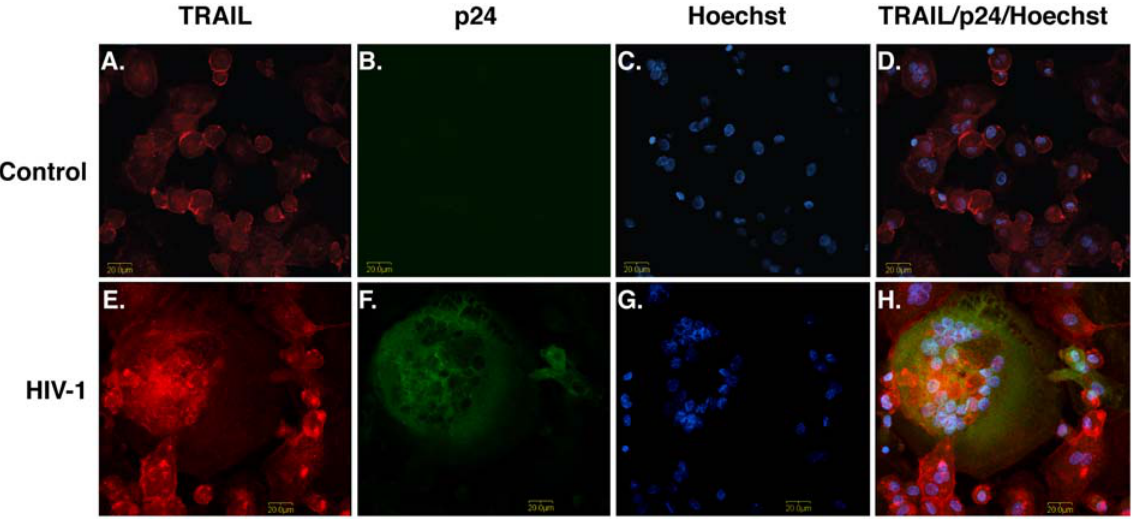
Figure 2. Membrane-bound TRAIL increases in HIV-1-infected macrophage culture. Human MDM were infected with HIV-1 for 5 days and then stained with antibodies to p24 (HIV-1 infection marker, green) and TRAIL (red). Nuclei (blue) were labeled with Hoechst 33342. A–D. Control uninfected MDM. E–H. HIV-1-infected MDM. Panels D and H are merged pictures of A–C and E–G, respectively. Images were acquired from a Bio-Rad MRC1024ES LASER scanning confocal microscope. Magnifications: A–H. 600 6 . Panels are representative of 4 separate donors.